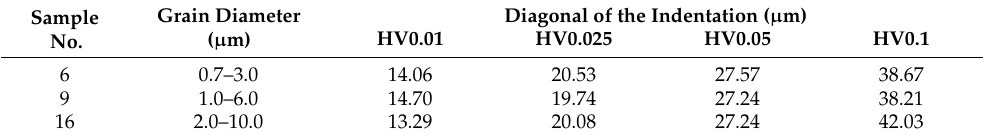
Table 3. The relationship between the diameter of the grain and the diagonal of the indentation. Sample No.